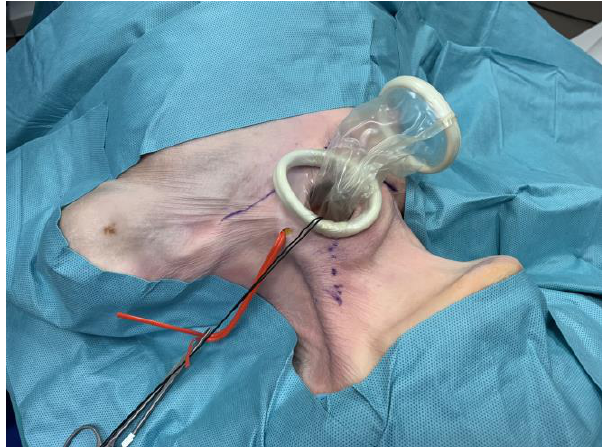
Figure 1. Transcervical incision at neck with the inserted x-small Alexis Wound Retractor .